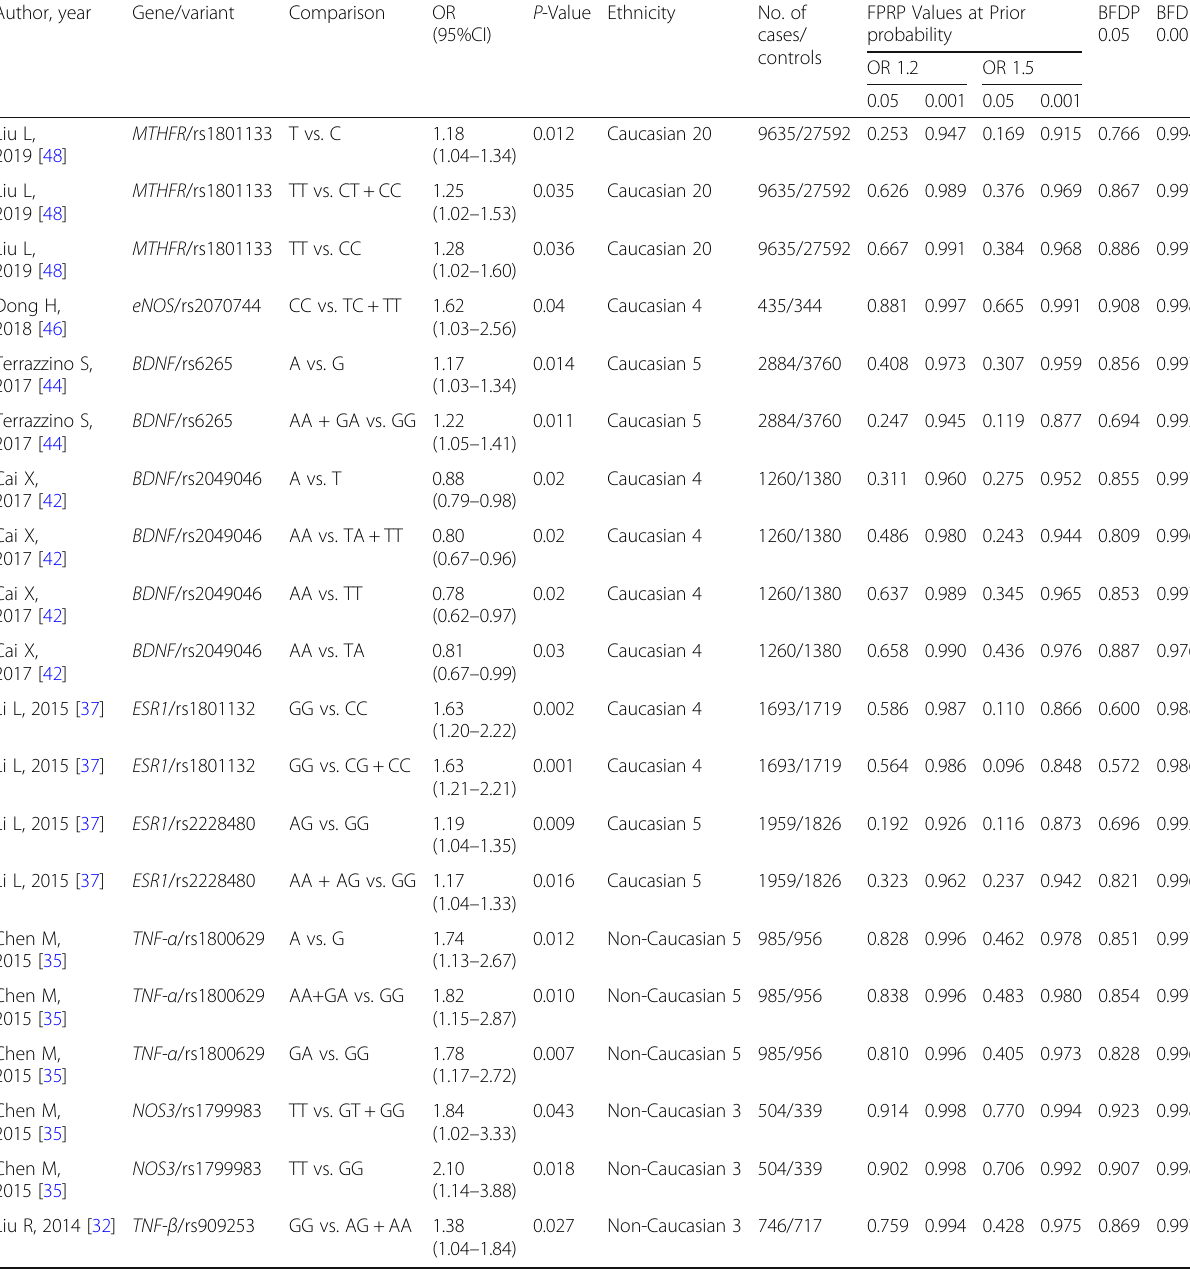
Table 4 Subgroup analysis of genetic variants with statistically significance ( P -value< 0.05) from observational studies based on